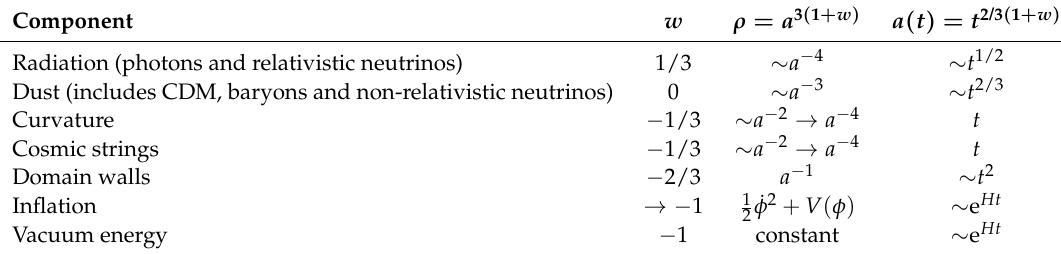
a − 4 t 1/2 ∼ ∼ a − 3 t 2/3 ∼ ∼ a − 2 a − 4 t 1/3 − ∼ → a − 2 a − 4 t 1/3 − ∼ → t 2 2/3 a − 1 − ∼ ˙ φ 2 + V ( φ ) 1 1 e Ht 2 → − ∼